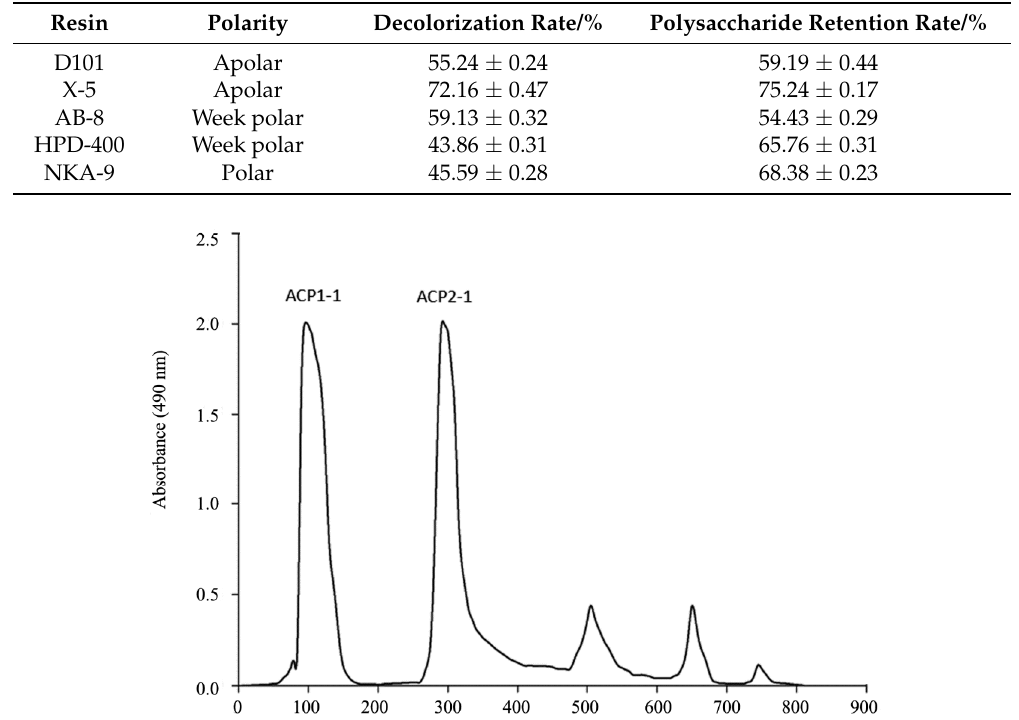
Table 2. Decolorization effects by different methods in ACP.